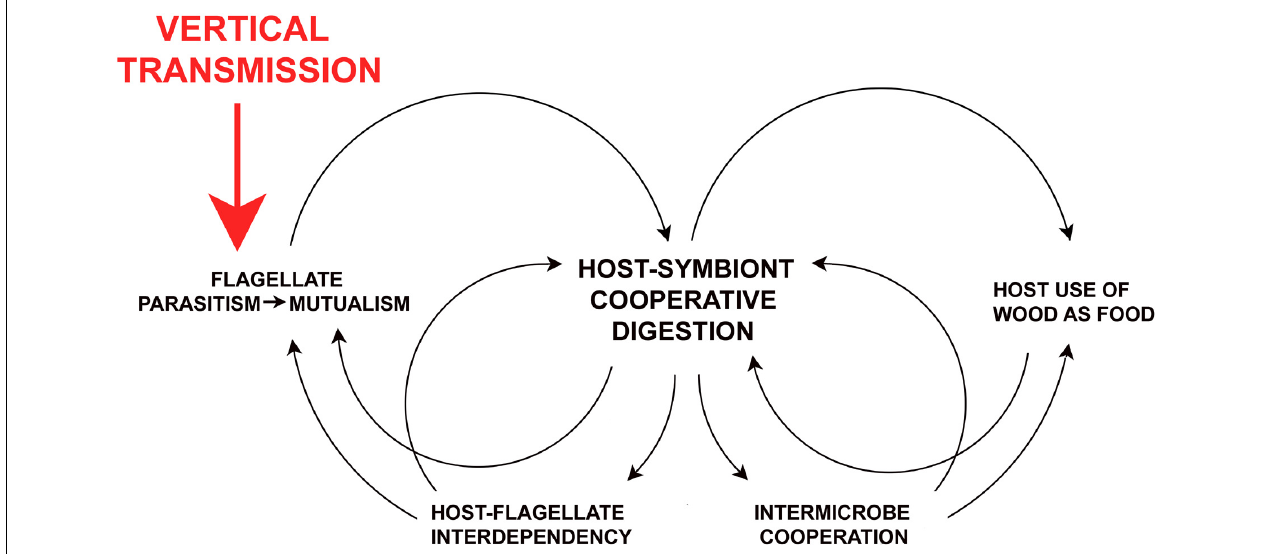
FIGURE 4 | Self-reinforcing dynamics of vertical transmission on host-gut symbiont relationships in the termite ancestors. Consequences of vertical transmission (proctodeal trophallaxis) on social evolution and life history of the host are addressed in Nalepa (2011, 2015, 2017).